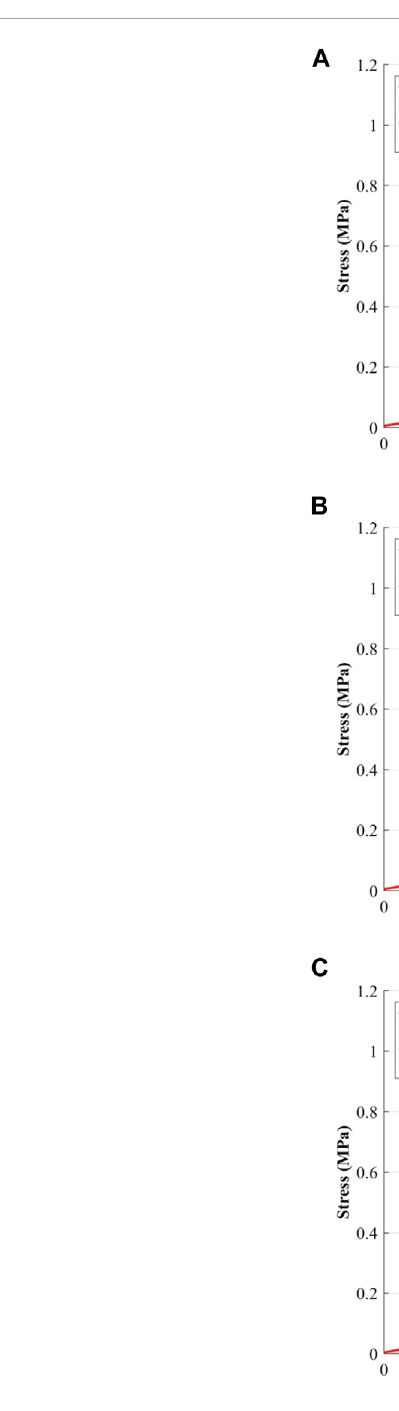
FIGURE 1 The mean stress-strain curves (solid continuous lines) of cranial cruciate ligaments (CCL) at (A) 0.1%/min, (B) 1%/min, and (C) 10%/min strain ratesduringloadingtests.Theblacklineandgreyshadedstandarddeviationshowresultsfromthecontrol(proteoglycanswerenotdepleted)group,